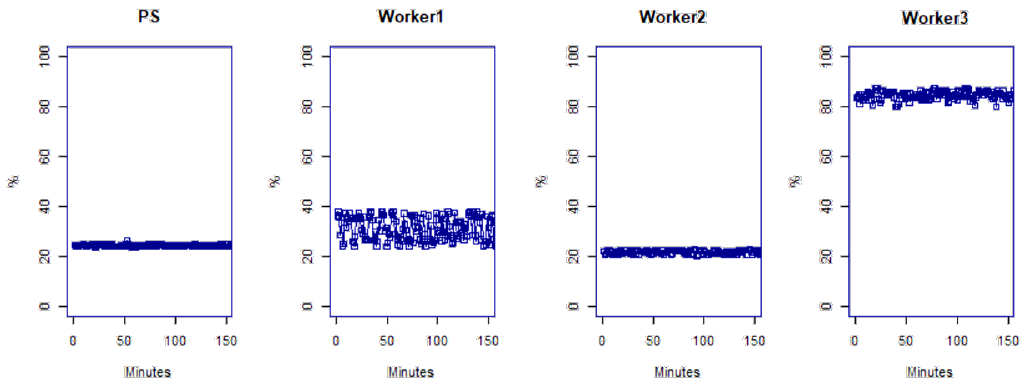
Figure 17. CPU load per worker for the model parallelism